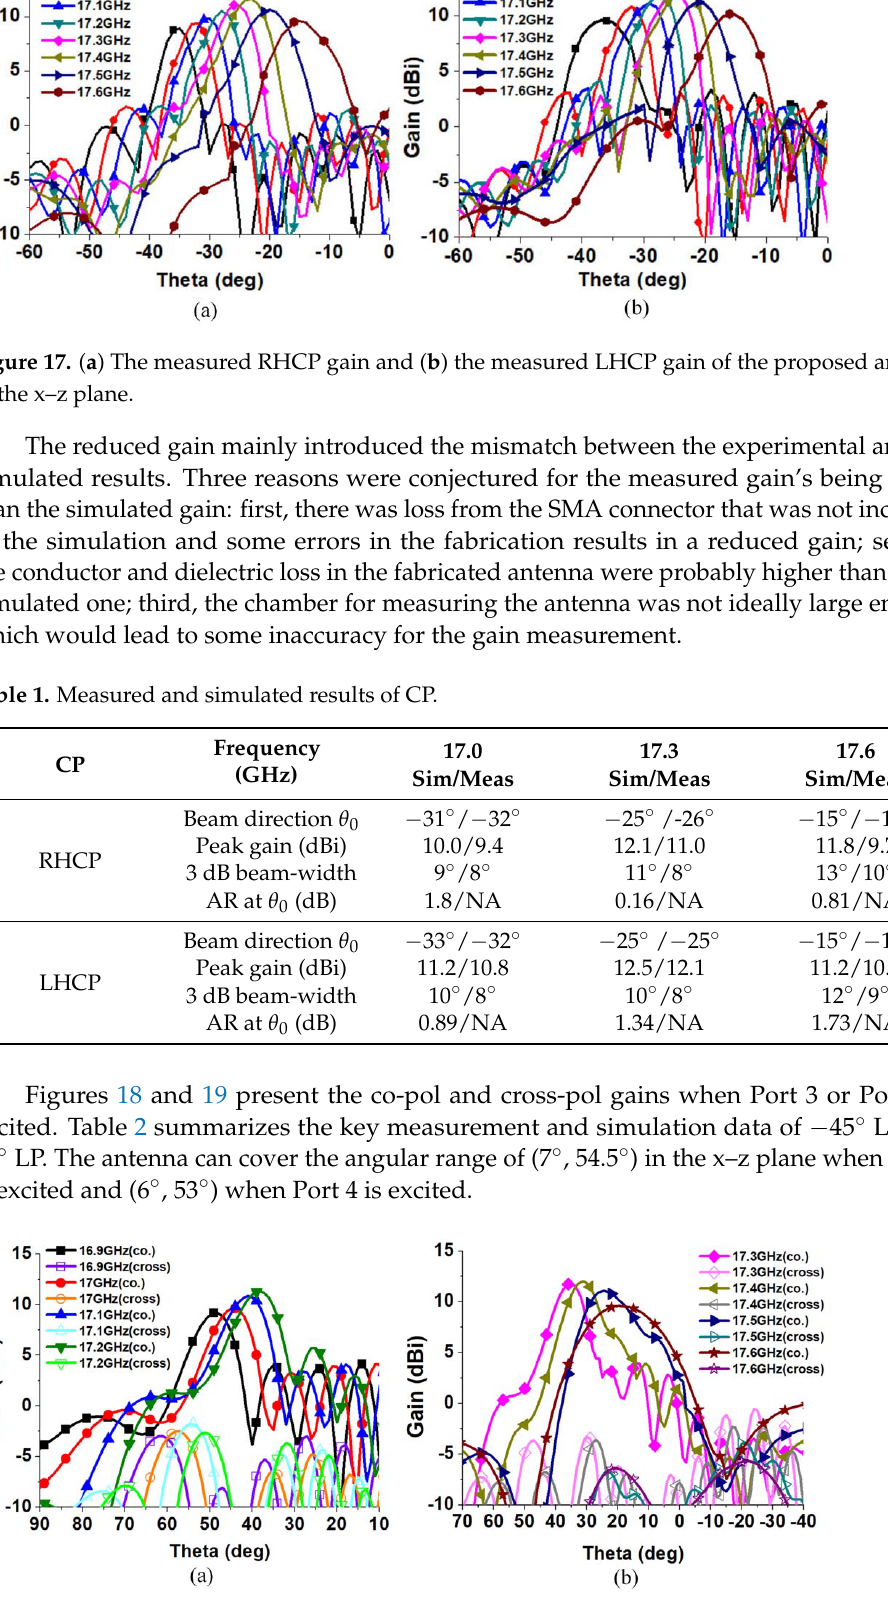
Figure 18. The measured co–pol and cross–pol gain of the proposed antenna when excited at Port 3 with the frequency range of ( a ) 16.9 GHz to 17.2 GHz and ( b ) 17.3 GHz to 17.6 GHz in the x–z